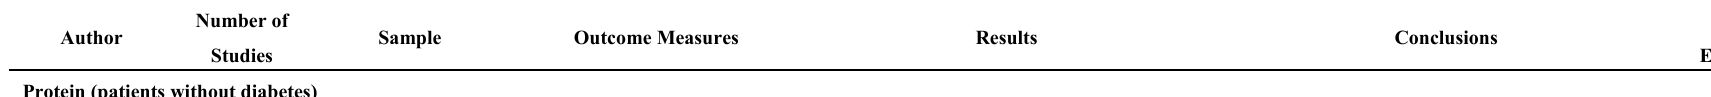
Table 1. Systematic reviews of nutrition interventions in patients with chronic kidney disease